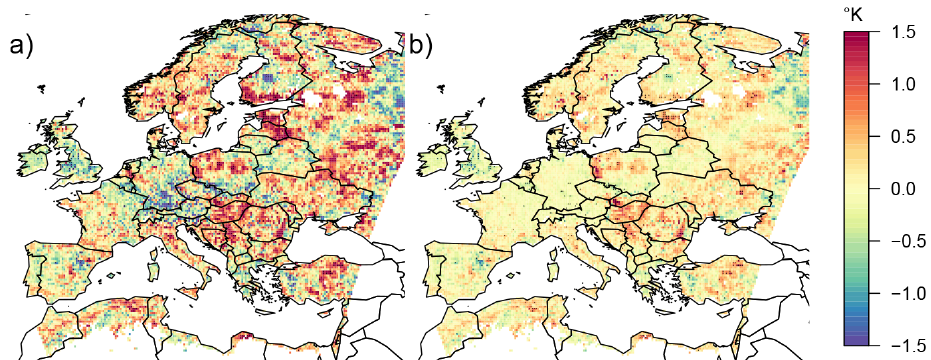
Figure A3. Ecosystem vulnerability (a) and risk (b) of carbon losses (negative NBP) to T for the period 1981 to 2010. Reddish colours indicate high vulnerability to heat stress; significant cells are marked with black